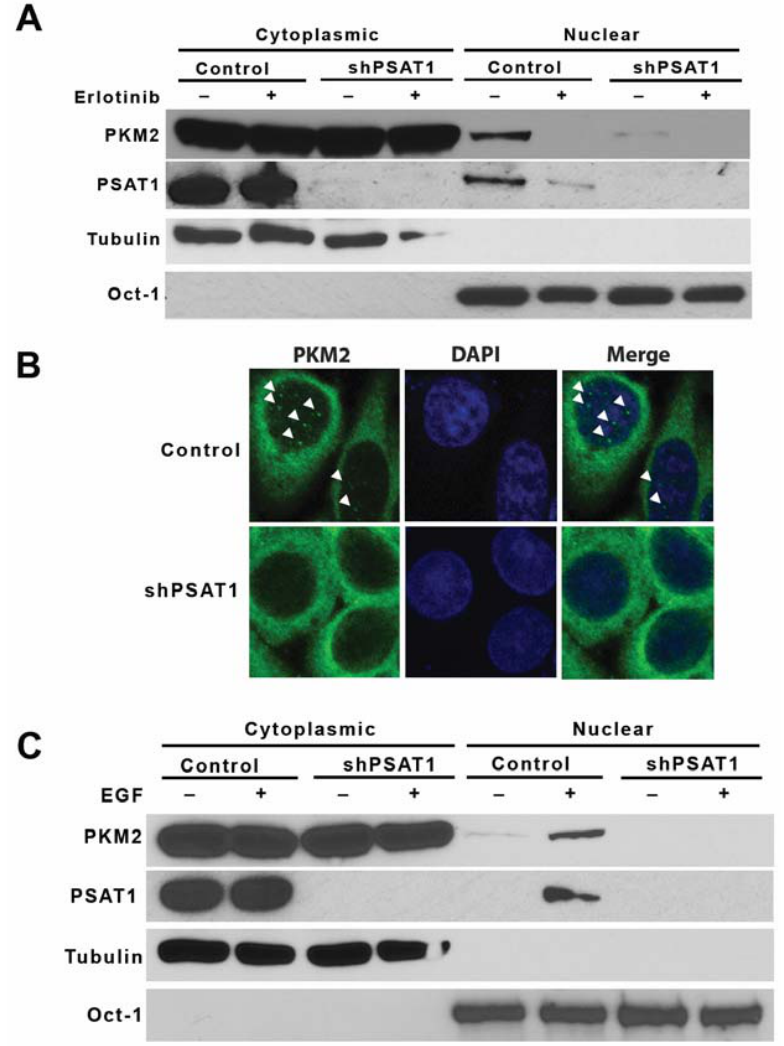
Figure 4. Silencing of PSAT1 suppresses the nuclear localization of PKM2 in EGFR activated NSCLC cells. ( A ) EGFR-mutant PC9 cells stably expressing the control or PSAT1 shRNA were treated with 1 µ M of erlotinib. Cytoplasmic and nuclear fractions were examined by an immunoblot analysis using anti-PKM2 and anti-PSAT1 antibodies. Oct-1 and α -tubulin served as loading controls for the nuclear and cytoplasmic compartments, respectively. Shown are representative images from three separate experiments. ( B ) Nuclear localization of PKM2 was examined in serum-starved PC9 cells expressing the control or PSAT1 shRNA by confocal microscopy. DAPI served as a control for nuclear staining. Arrowheads indicate nuclear PKM2 staining in representative images from three independent experiments. ( C ) Serum-starved A549 cells (EGFR wild-type) stably expressing control or PSAT1 shRNA were treated with or without EGF (100 ng/mL). Cytoplasmic and nuclear fractions were prepared and the PKM2 and PSAT1 localizations were analyzed by immunoblot. Oct-1 and α -tubulin served as loading controls for the nuclear and cytoplasmic compartments, respectively. Shown are representative images from three separate